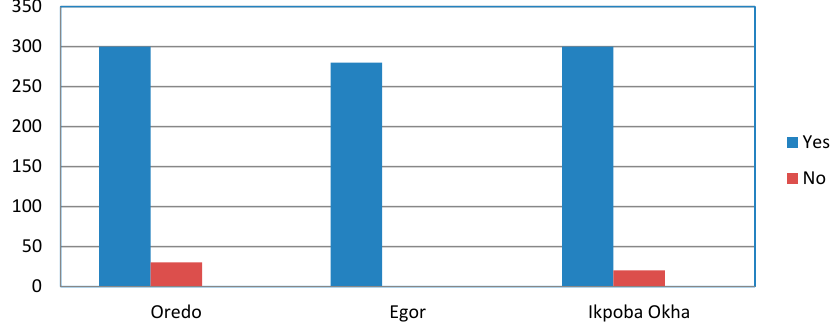
Figure 3. Respondents that experienced flood occurrence in the previous 19-year period.